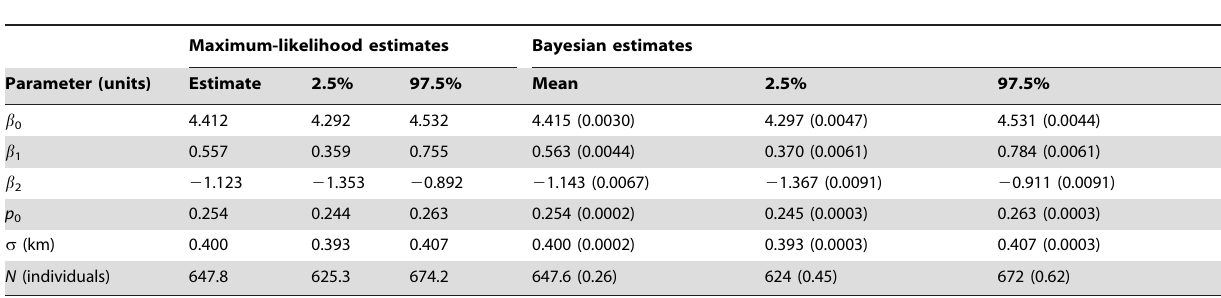
Table 1. Estimates of parameters of model fitted to recaptures of individuals in a simulated population.